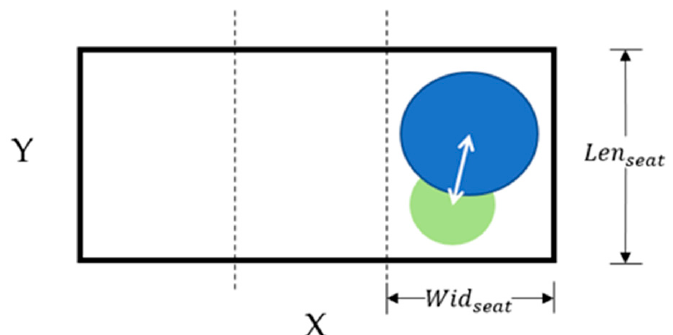
Figure 7. The top view of the Figure 6b case. The three rectangles divided by the dotted line are the top view of the three seats. The blue point cloud is the part of the passenger’s torso, and the green point cloud indicates the reflection of the passenger’s legs. The white arrows indicate the distance between the centers of the point clouds. Different colors represent point clouds grouped into different categories.